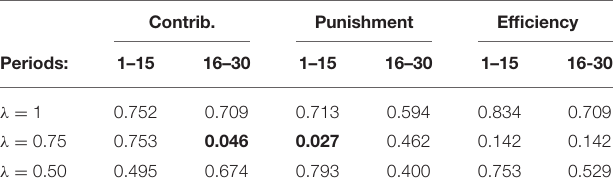
TABLE 1 | Aggregate effects of institution. TABLE 2 | Aggregate effects of